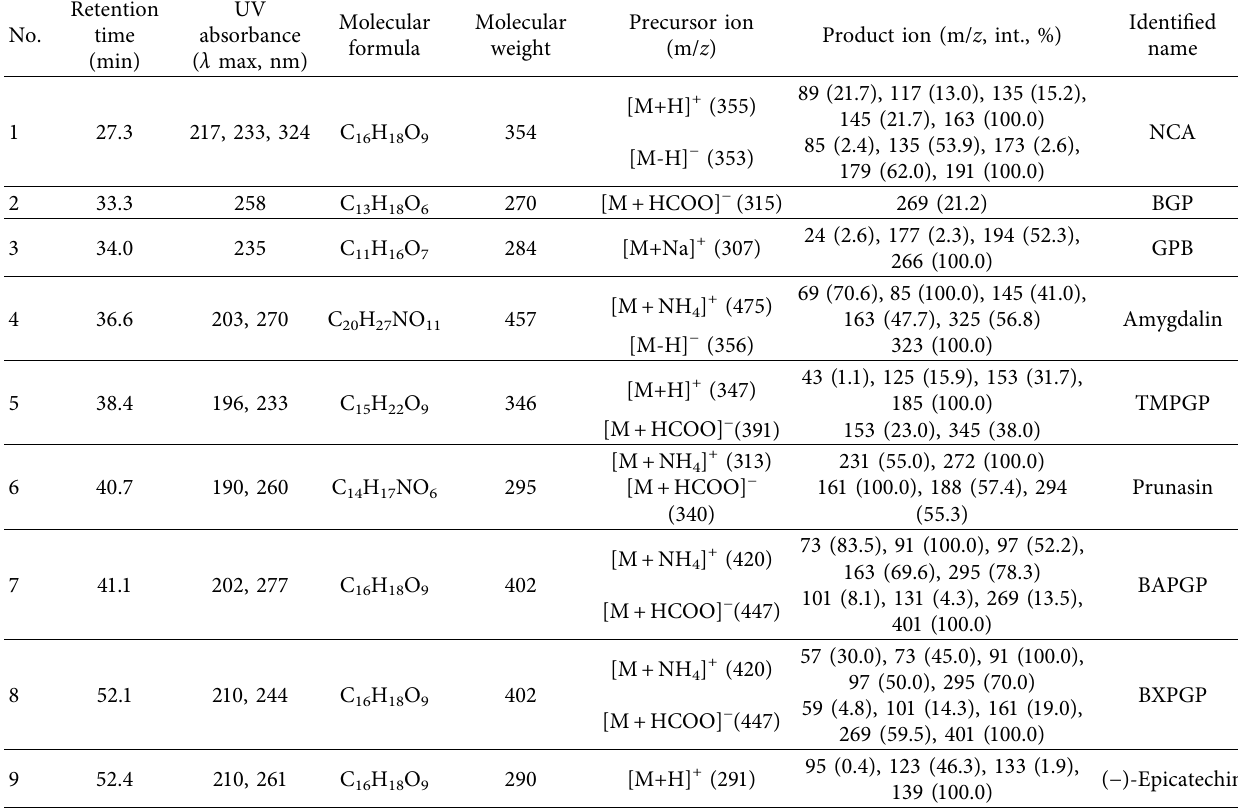
Table 2: Summary of UV, MS, and MS/MS spectra for nine compounds obtained from P. mume fruits.